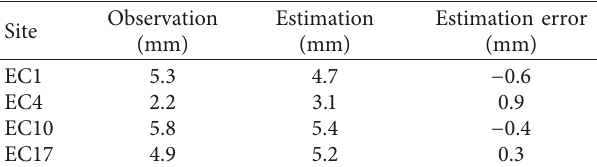
Figure 7: Comparison between daily observed ET by EC stations and that estimated by the Gaussian fitting method.